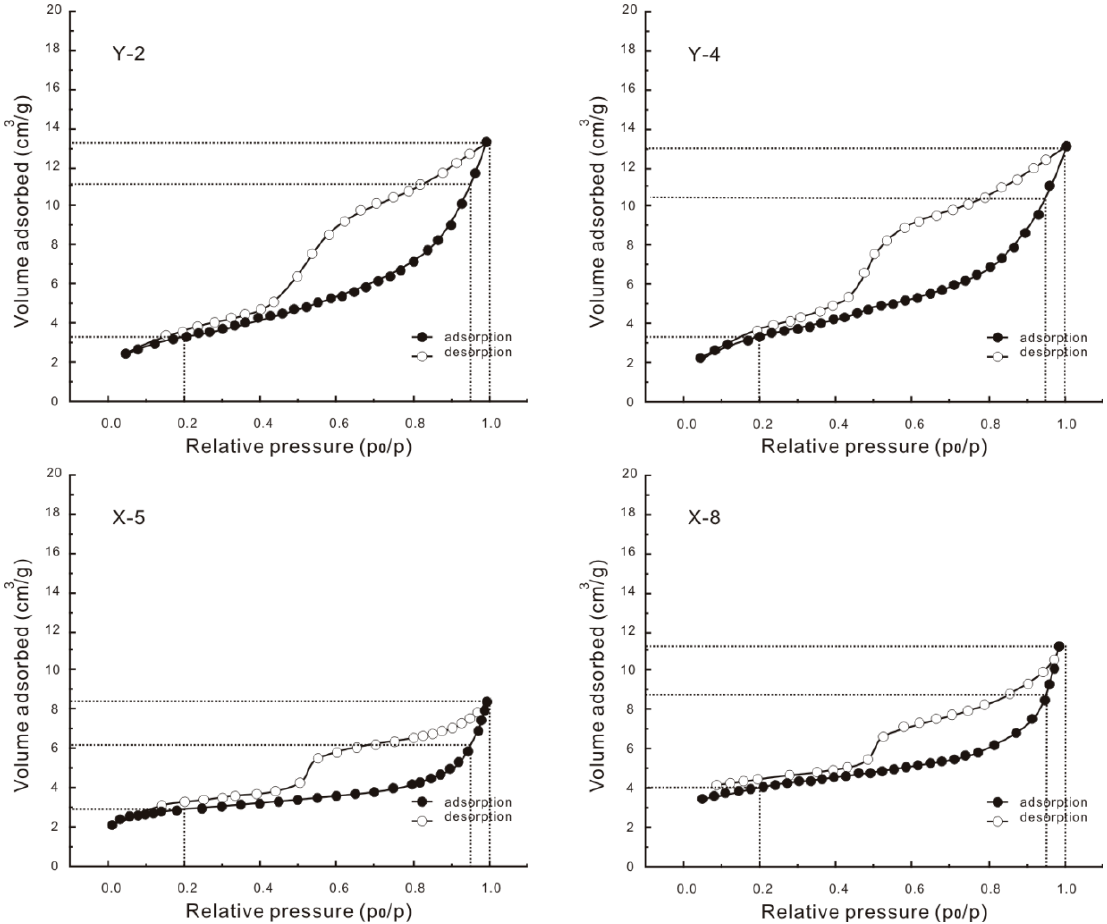
Figure 7. Typical N 2 adsorption-desorption isotherms of transitional Longtan Shale samples from YV-1 and XD-1.